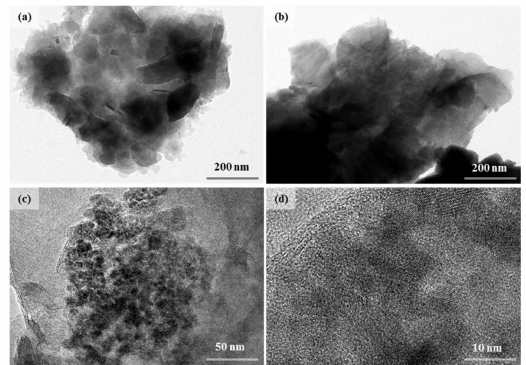
Figure 3. TEM images of DIA ( a ) and Fe-Ce / DIA ( b – d